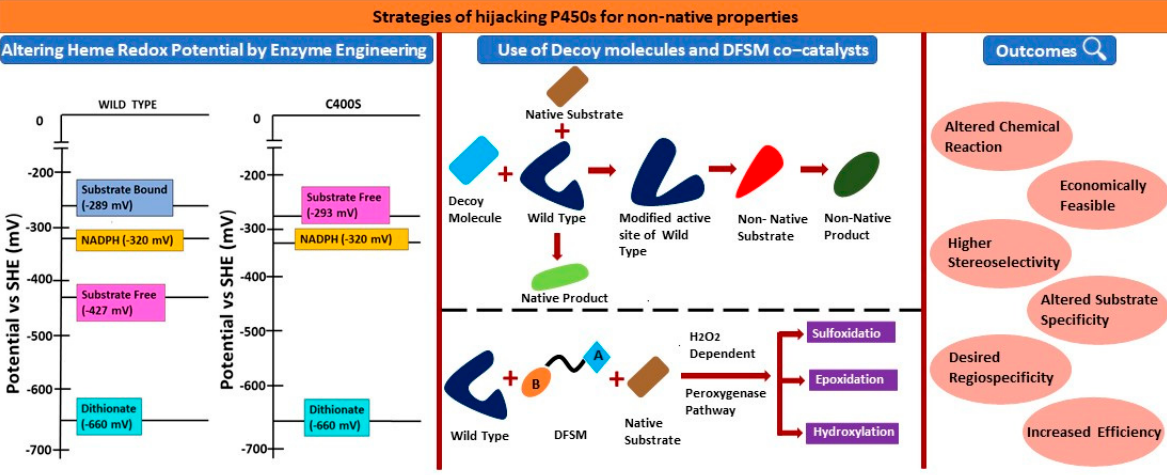
Figure 8. Summary of the review. Strategies for hijacking P450s for non-natural properties to alter the chemical reactions and for the asymmetric synthesis. Altering hem redox potential for non-native reactions and to switch the stereoselectivity, and employing decoy molecules and DFSM catalysts for non-native reactions and/ or for accepting non-native substrates.